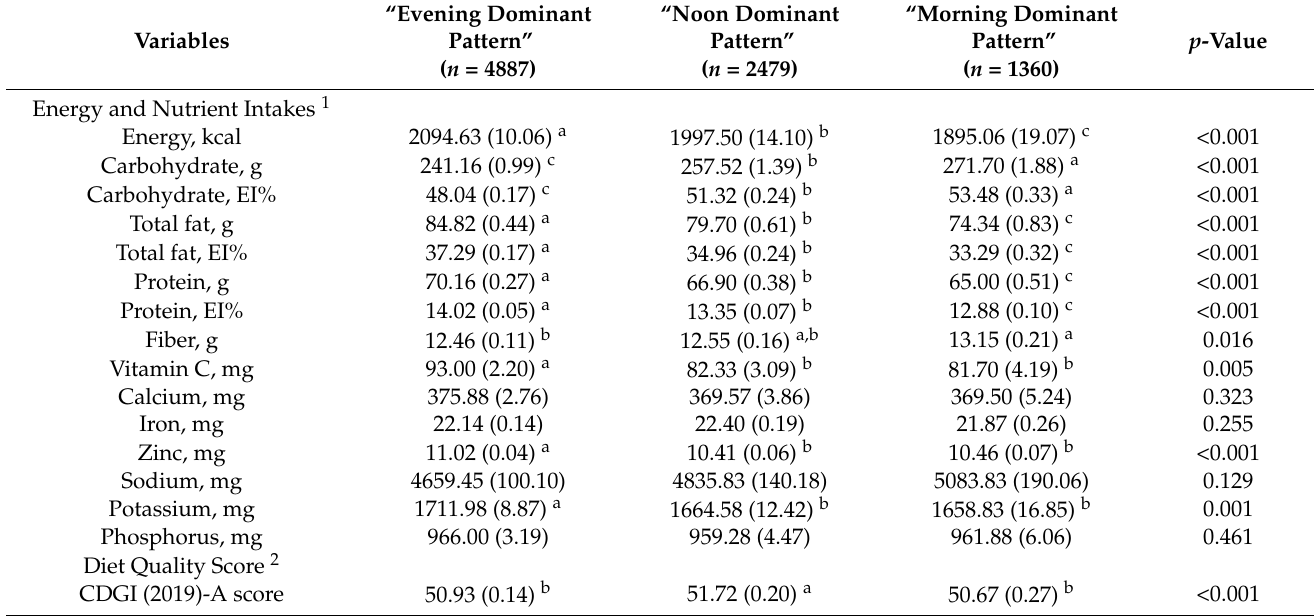
Table 4. Daily energy, energy-adjusted nutrient intakes, and diet quality score by latent